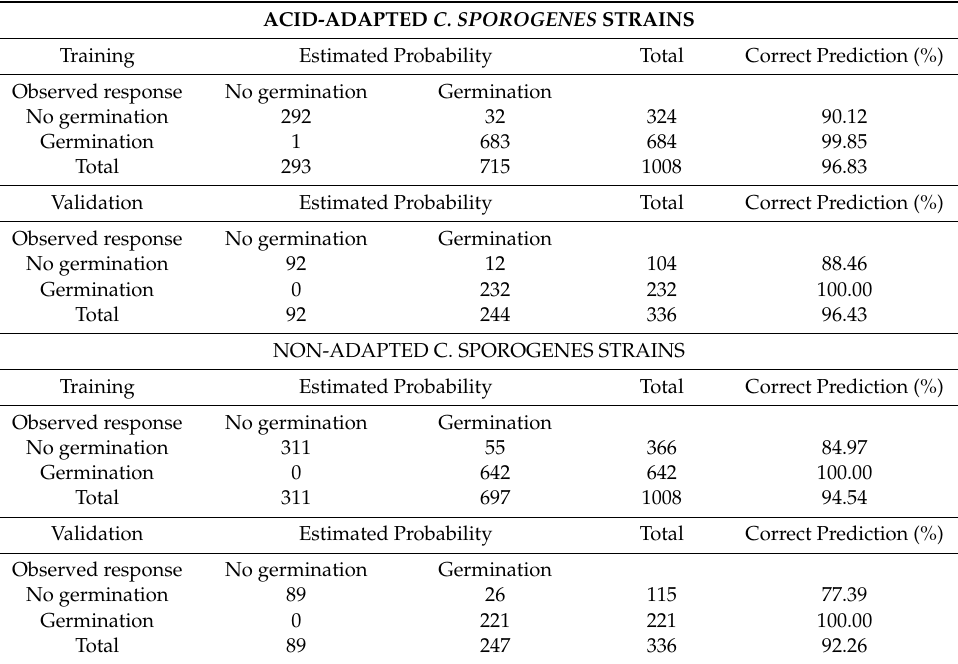
Table 4. Classification tables of observed vs. predicted conditions of the training and validation datasets for the acid-adapted and non-adapted C. sporogenes